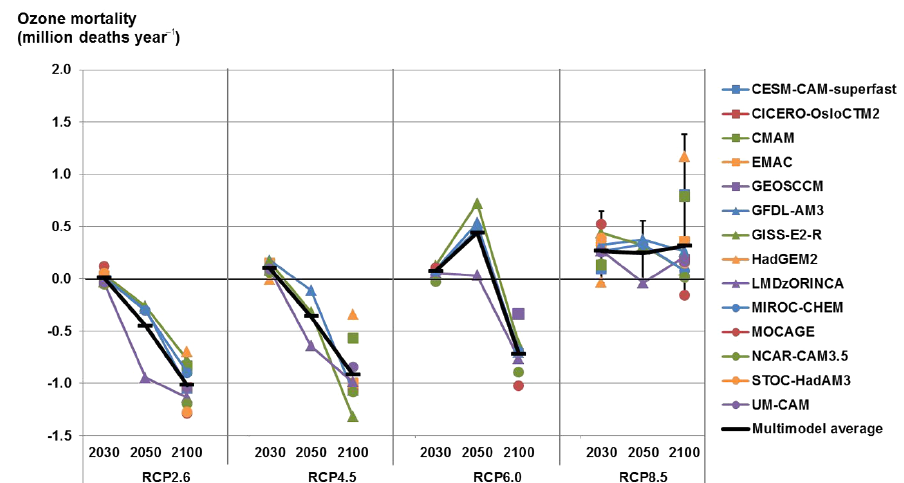
Figure 1. Estimates of future ozone respiratory mortality for all RCP scenarios in 2030, 2050 and 2100, showing global mortality for 13 models and the multi-model average (milliondeathsyear − 1 ), for future air pollutant concentrations relative to 2000 concentrations. Uncer- tainty for the multi-model average shown for RCP8.5 is the 95% CI, including uncertainty in RR and across models. Only models with results for the 3 years have lines connecting the